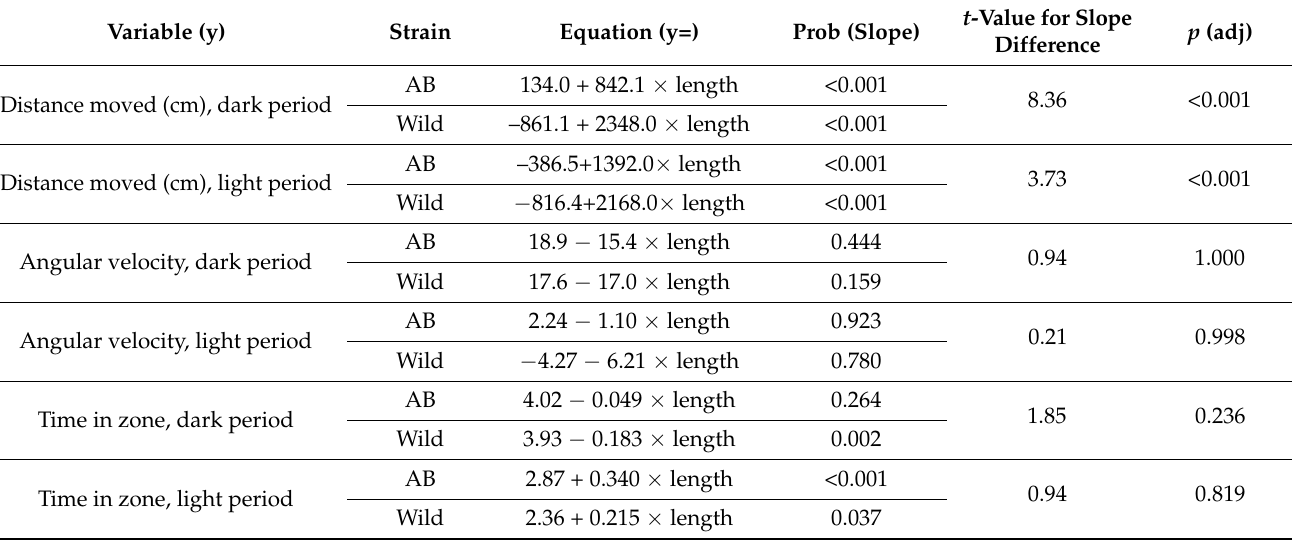
Table 1. Behavioural variables in light and dark regimes compared between the two strains. This table shows that there are no overall differences between the strains concerning the level of the variables (distance moved, angular velocity and time in zone). Values for body length were log-transformed prior to analysis, except for time in zone.